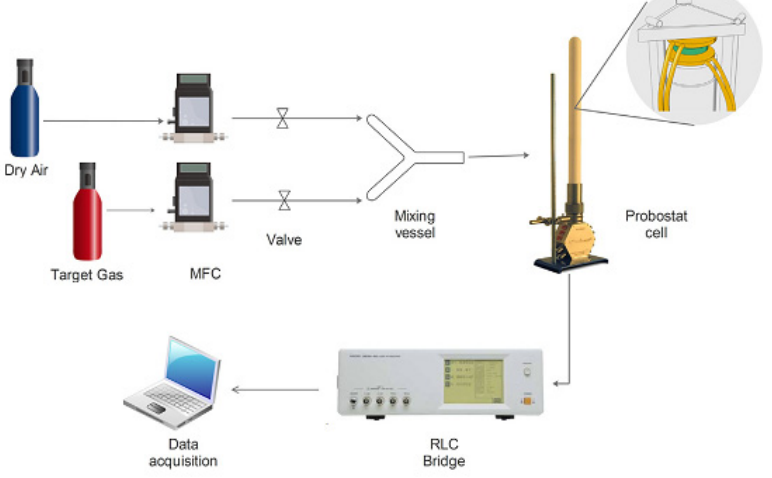
Figure 13. Gas sensing experimental setup used for pellet-type samples, from ref. [69].